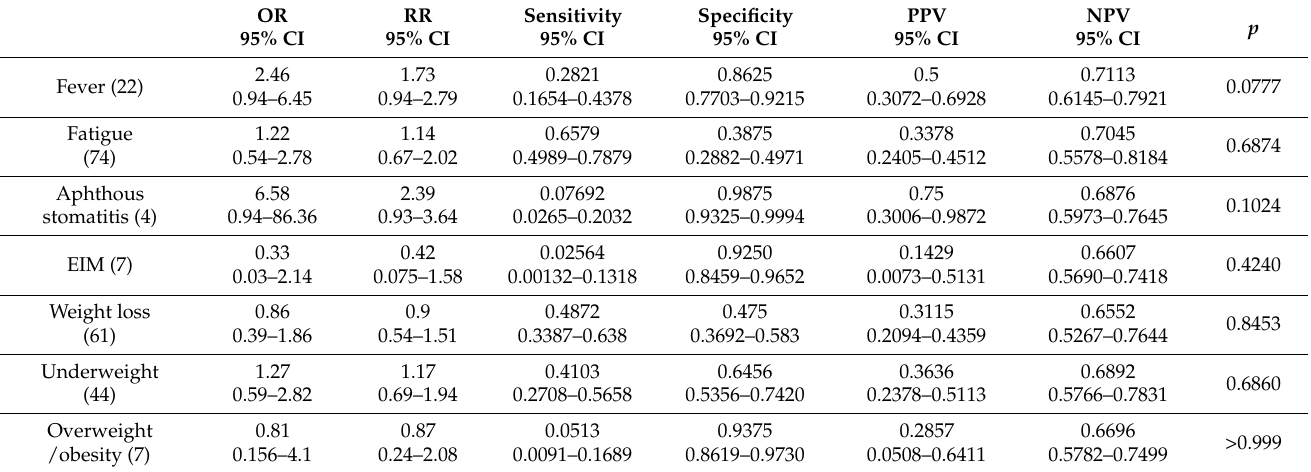
Table 3. CD symptoms. In brackets the number of patients presenting with each symptom is